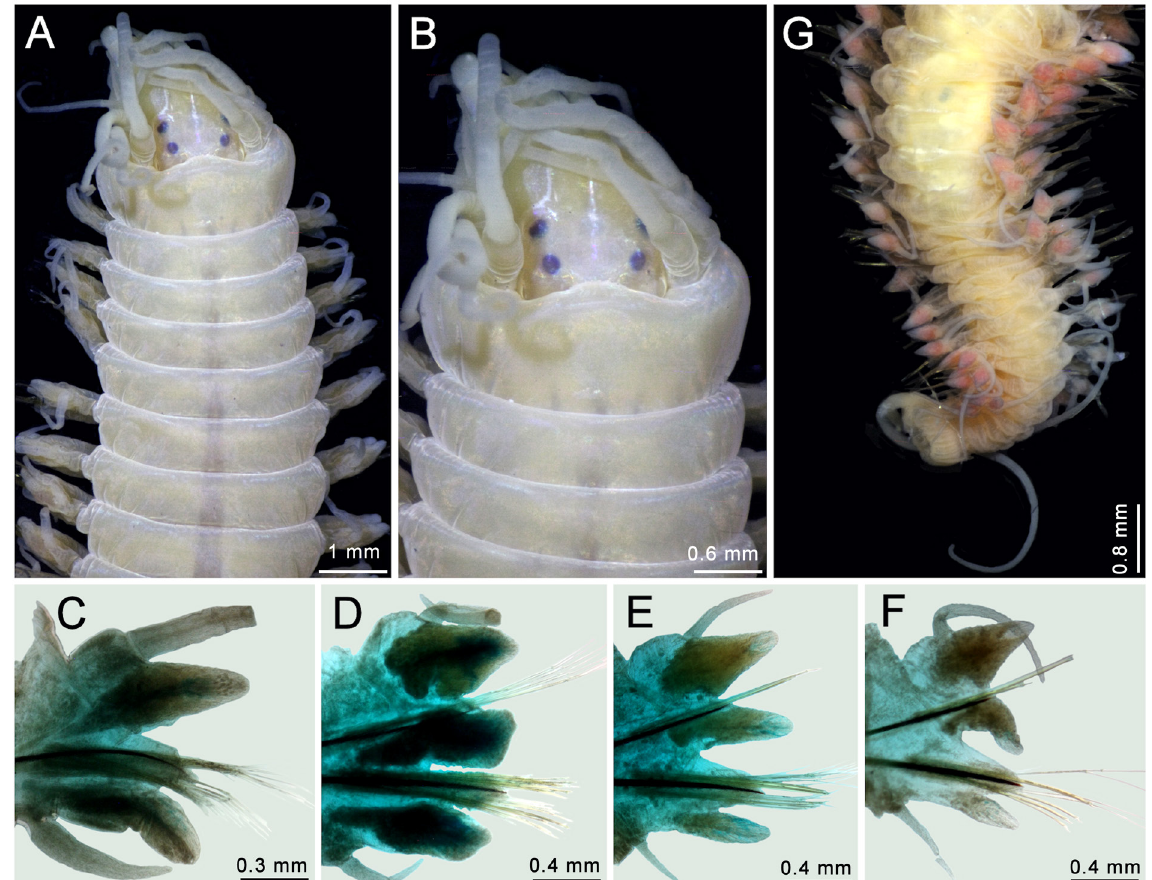
Fig. 12. Nereis riisei Grube & Örsted in Grube, 1857, non-type specimen (ECOSUR P2256). A . Anterior region, dorsal view. B . Anterior end, dorsal view. C . Chaetiger 2, left parapodium, anterior view. D . Chaetiger 30, left parapodium, anterior view. E . Chaetiger 90, left parapodium, anterior view. F . Chaetiger 168, left parapodium, anterior view. G . Posterior region, dorsal view, after Shirlastain-A